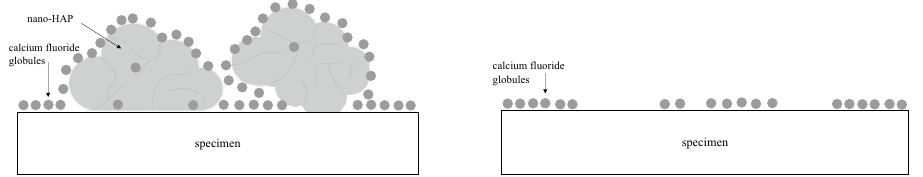
Figure 9. Schematic figure after primary nano-HAP application and subsequent fluoride application. Nano- HAP slightly compromises fluoridation. Left: nano-HAP particles are masked by calcium fluoride globules. Right: after spraying, nano-HAP particles are completely removed and a surface inhomogeneously covered with calcium fluoride globules remains. Nano-HAP hydroxyapatite